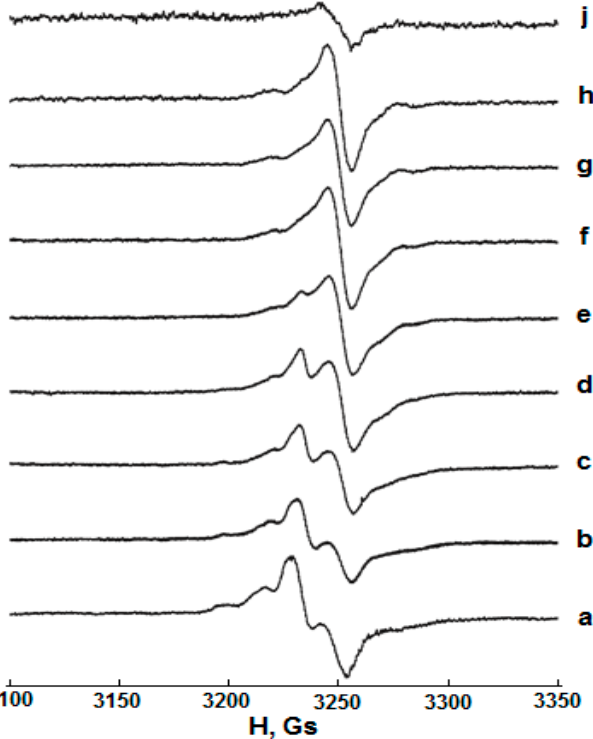
Figure 4. Central part of the ESR spectra of sample of the Ag ÷ CCl 4 ÷ 4-cyano-4 ′ -pentylbiphenyl